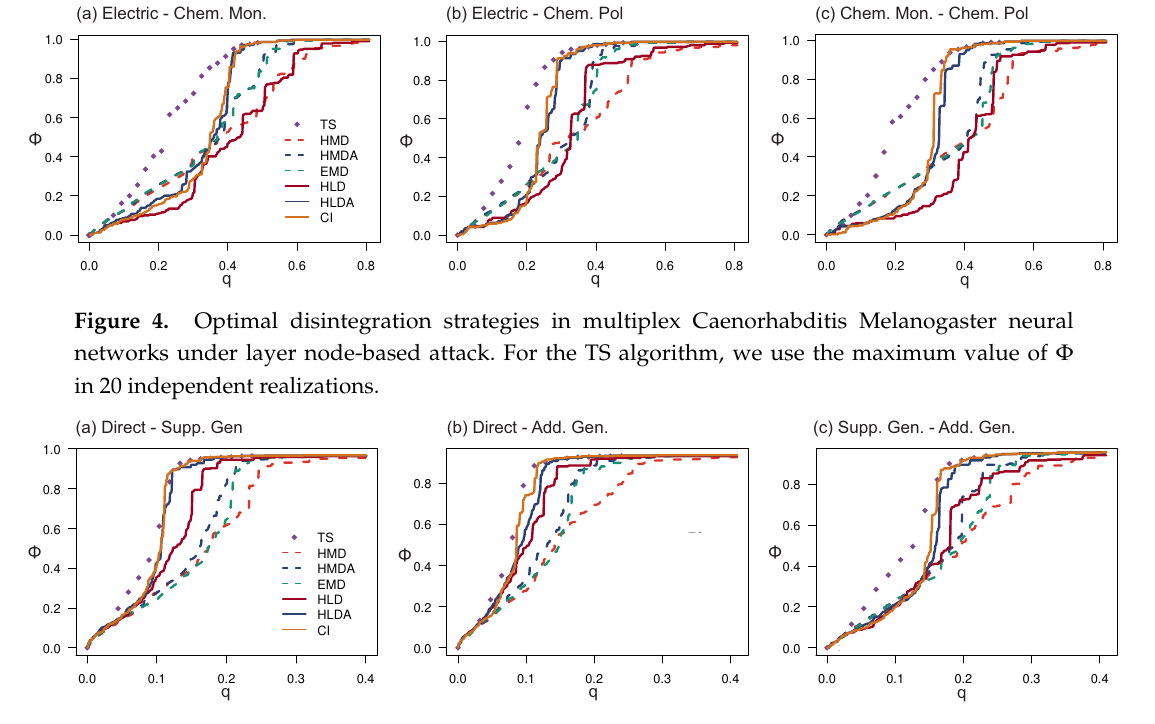
Figure 5. Optimal disintegration strategies in multiplex Drosophila Melanogaster genetic and protein interaction networks under layer node-based attack. For the TS algorithm, we use the maximum value of Φ in 20 independent